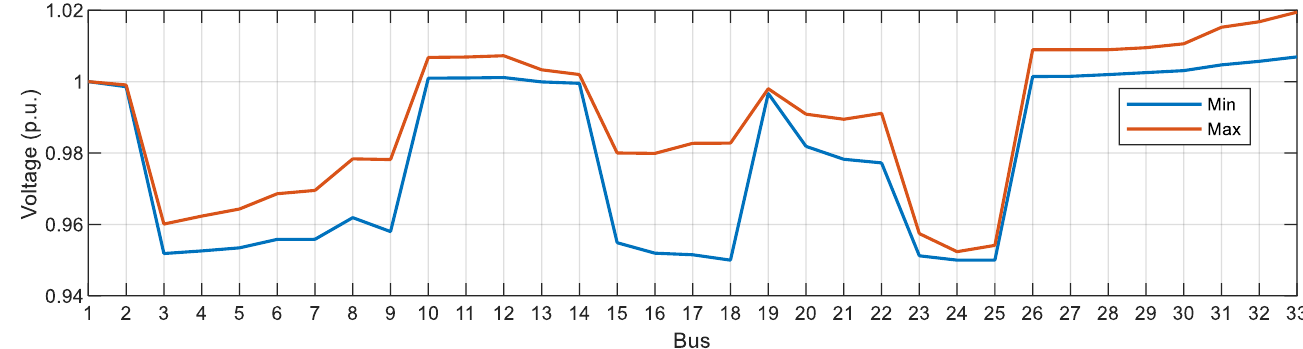
Figure 15. Boxplot representation of hourly voltage profiles for Scheme II.